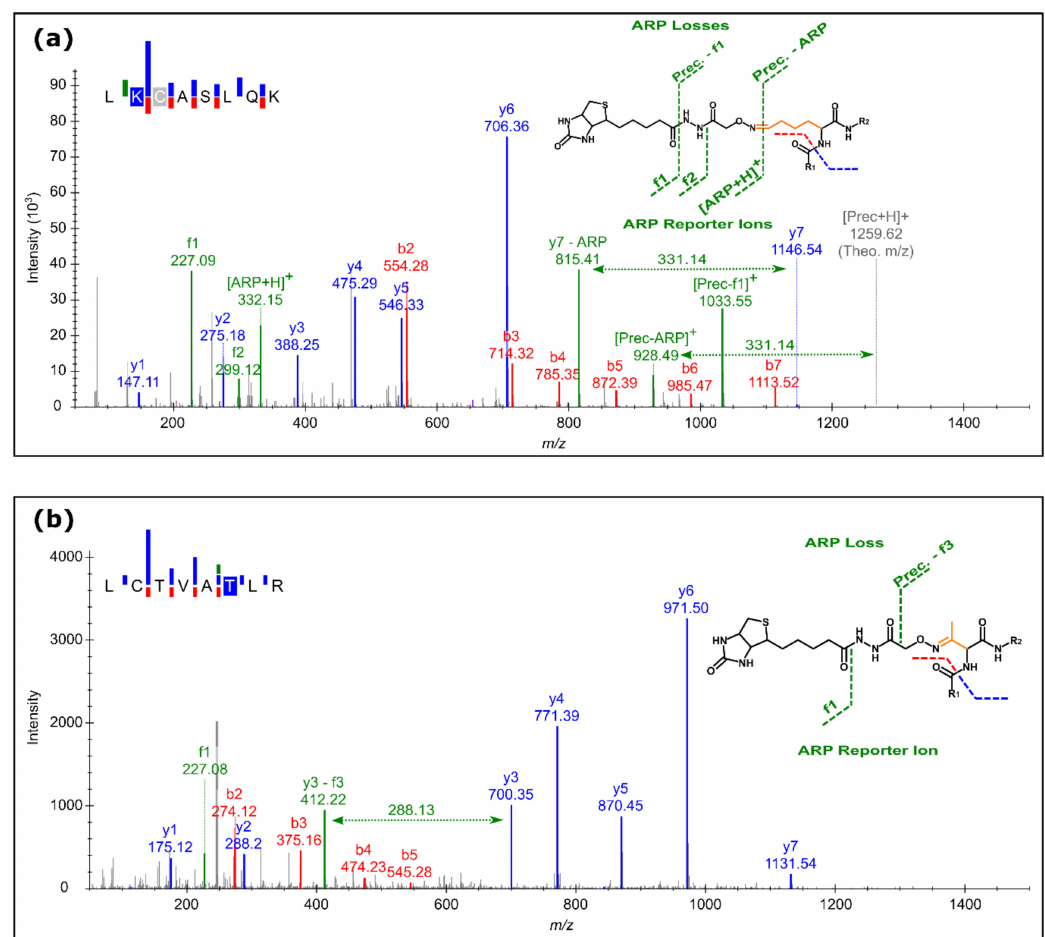
Figure 2. Fragmentation patterns of two doubly protonated precursors at m / z 630.315 ( a ) and m / z 622.816 ( b ) using collision-induced dissociation (CID). The indicated fragment ions confirmed ARP-derivatized tryptic human serum albumin (HSA) peptides, i.e., residues 197 to 204 with Lys199 modified as glutamic semialdehyde and residues 73 to 80 with Thr79 modified as 2-amino-3-ketobutyric. The small inserts indicate the proposed structures and fragmentation